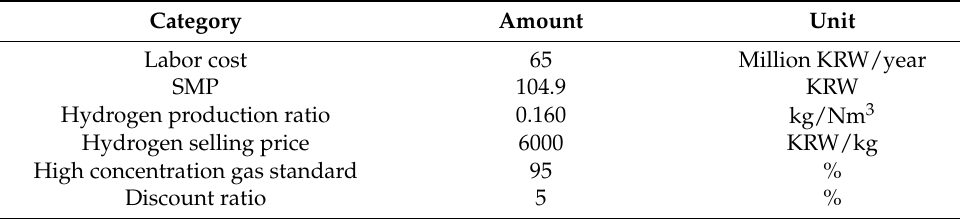
Table 4. Common fixed definition.